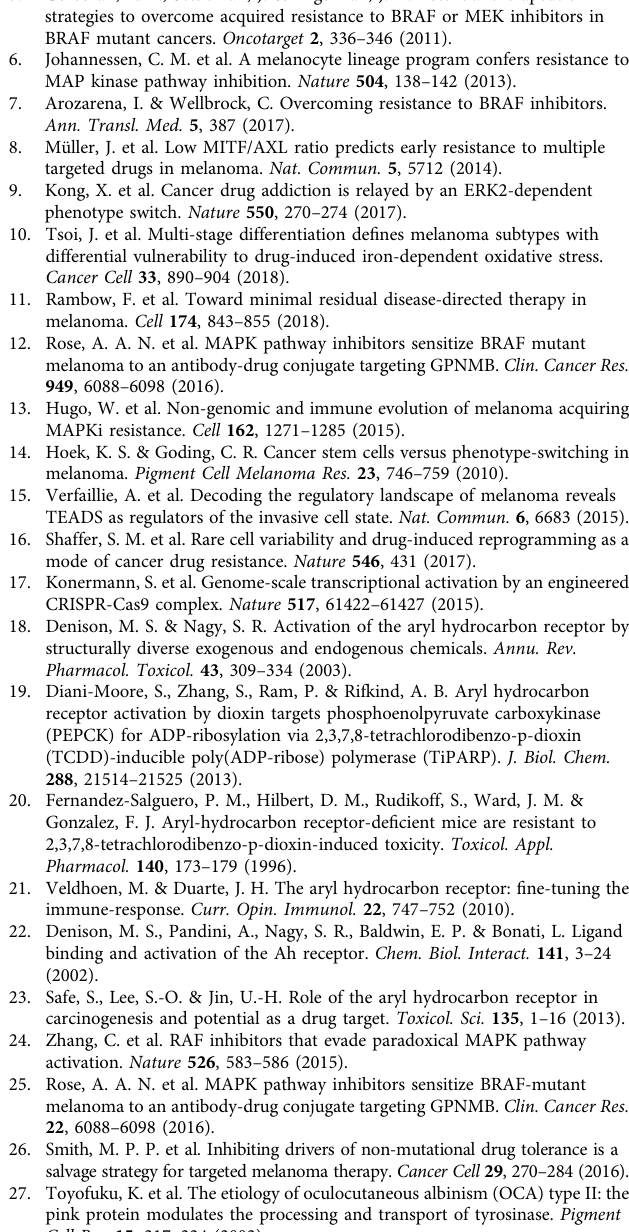
Fig. 6 Therapeutic opportunity to limit BRAFi resistance. a Heatmap depicting the effects of different AhR ligands on OCA2 and CYP1A1 mRNA in 501Mel cells and pigmentation (48h). Three groups: exo- and endo-gene ligands (TCDD, B( a )P and FICZ, L-Kynurenine, respectively), BRAFi and AhR antagonists (Resveratrol and CH-223191). b Binding model of the antagonist Resveratrol (RSV) to the PAS B of AHR. RSV is predicted to bind to the α -pocket. Free binding energy is reported in Supplementary Table 1. c RSV prevents CYP1A1 mRNA induction (48h) by TCDD. 501Mel cells were pre-treated with 5 μ M RSV 2h before 10nM TCDD. d Gene expression pro fi le of 501Mel cells exposed to vehicle, TCDD (10nM), RSV (5 μ M), or RSV (5 μ M) + TCDD (10nM) ( n = 2) for 48h. Heatmap focused on differentially expressed genes as a function of treatment. e – g 501Mel cells were treated with Vem (1 μ M) alone or in combination with RSV (5 μ M) for 48h for pigmentation analyses ( e ), OCA2 mRNA expression levels ( f ), and phospho-ERK and ERK total detection by Western blotting ( g ). h 501Mel cells were pretreated for 2h with RSV (5 μ M) before Vem addition (1 μ M). 501Mel cell density was evaluated by methylene blue staining followed by quanti fi cation at 620nm ( n =